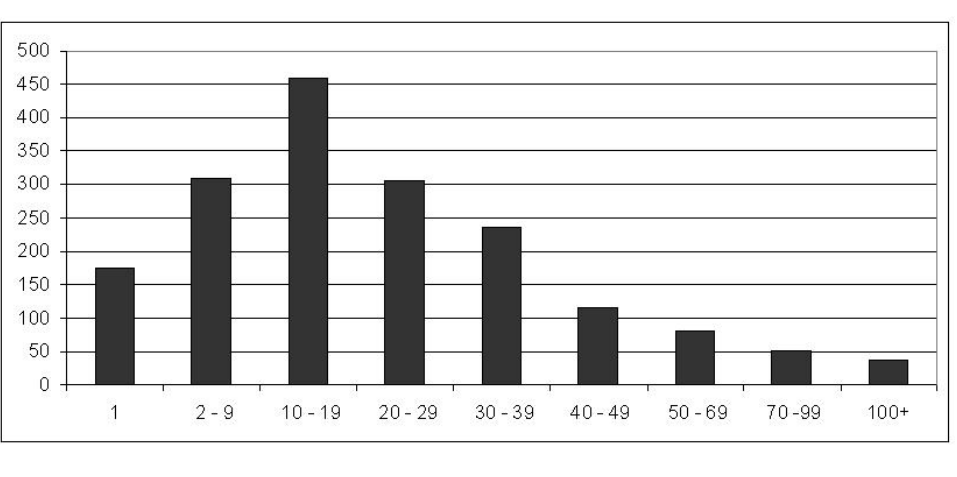
Figure 1 – Distribution of the number of words contained in the responses The vocabulary consisted of 5,546 types for a total of 44,939